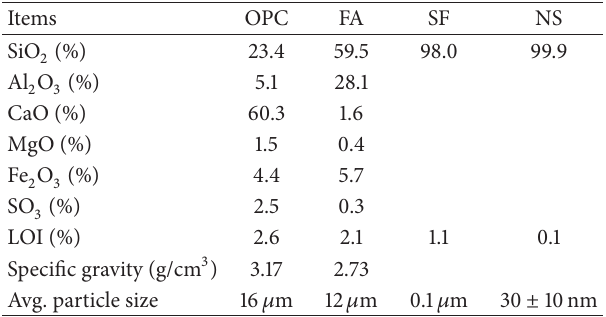
Table 1: Chemical compositions and properties of cementitious materials.